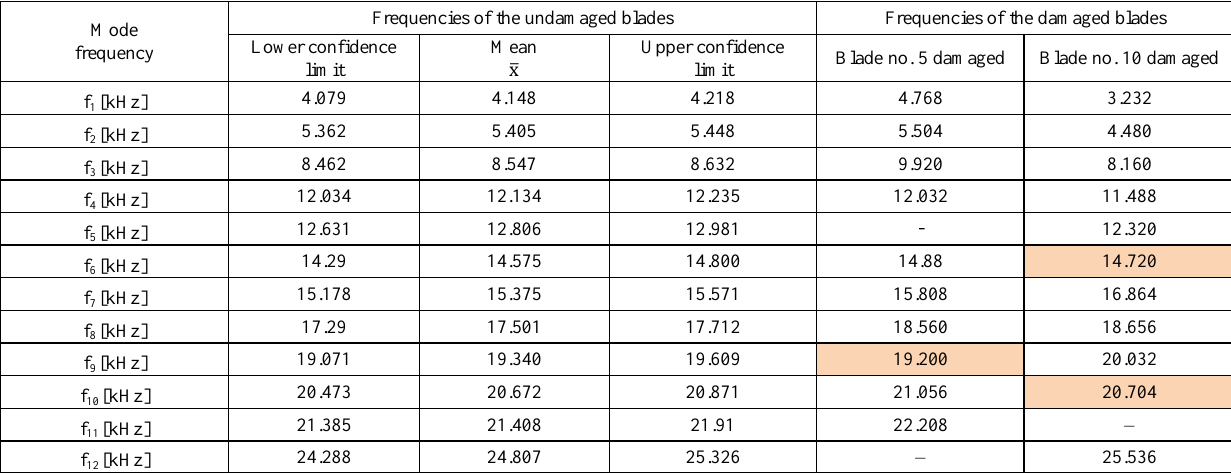
ral frequencies. The average, the median and the center